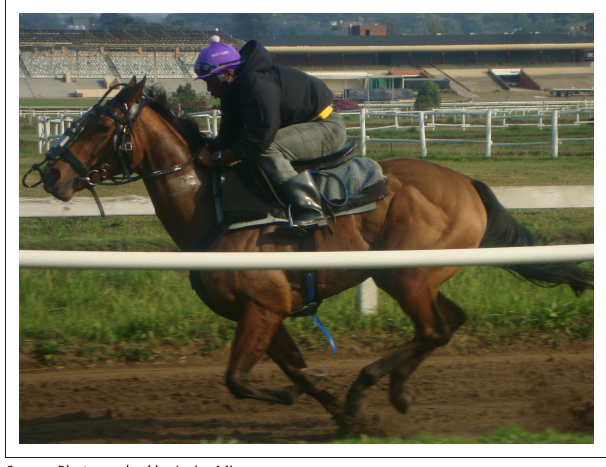
Source : Photographed by Javier Mirazo FIGURE 3: Dynamic overground endoscopy examination at gallop.